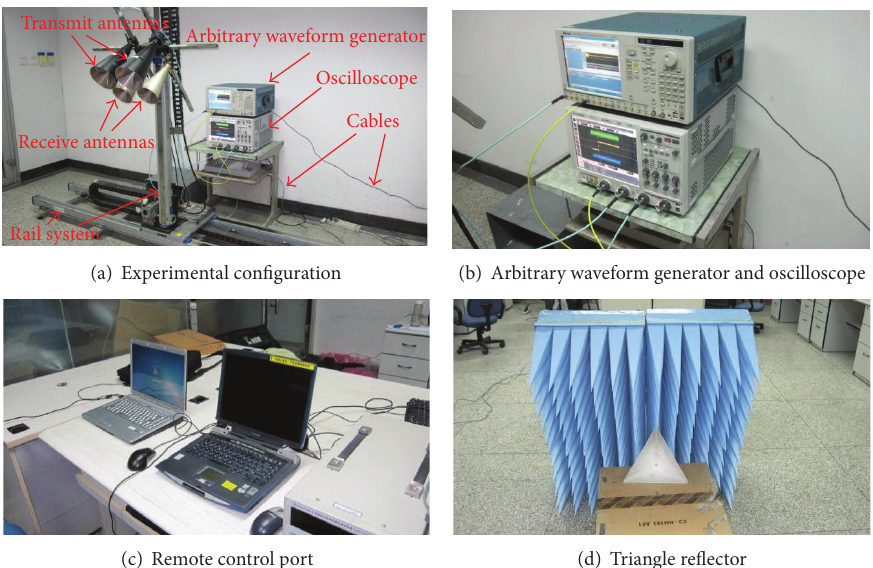
Figure 4: MIMO SAR experimental configuration and observed target.